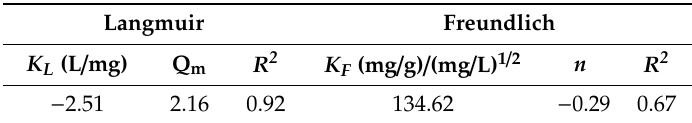
Table 2. Values of constants of Langmuir and Freundlich’s isotherm models for phosphate adsorption by iron-Z-A.